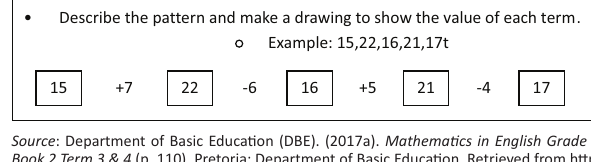
FIGURE 2: Number patterns represented on TABLE 3: Grades 7–9 range of knowledge correspondence and scale of agreement. Ranges of patterns Ranges of patterns identified on workbook activities (NGP) identified on SPMCS Grade 7 Ranges of patterns Scale of agreement Numeric patterns